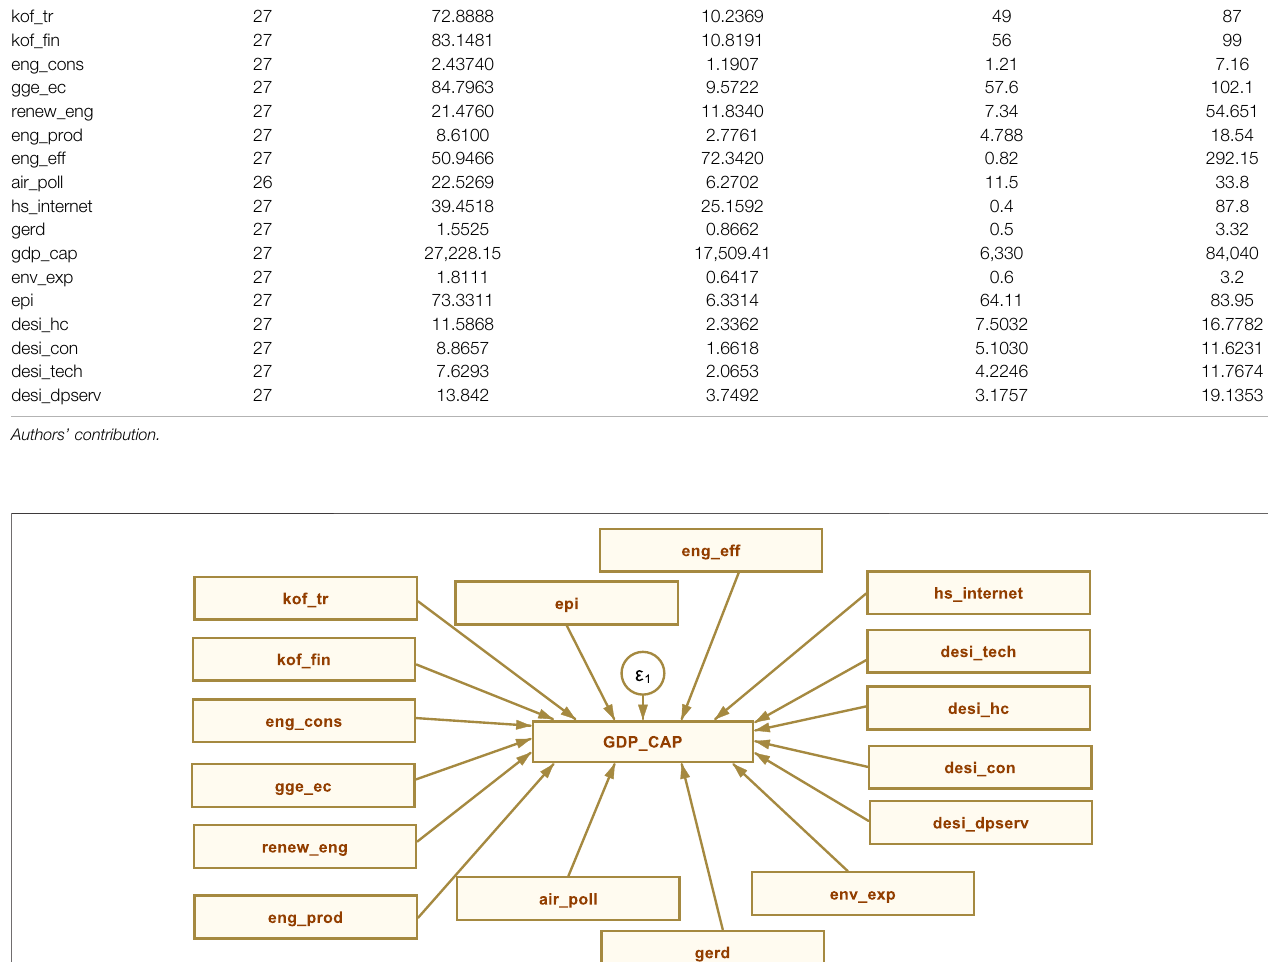
TABLE 1 | Summary statistics of the data used in the analysis. Variables